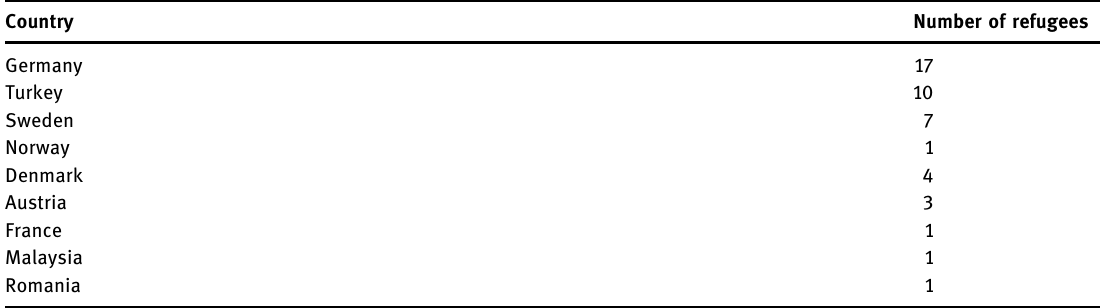
Table 2: Numbers of participants in asylum countries